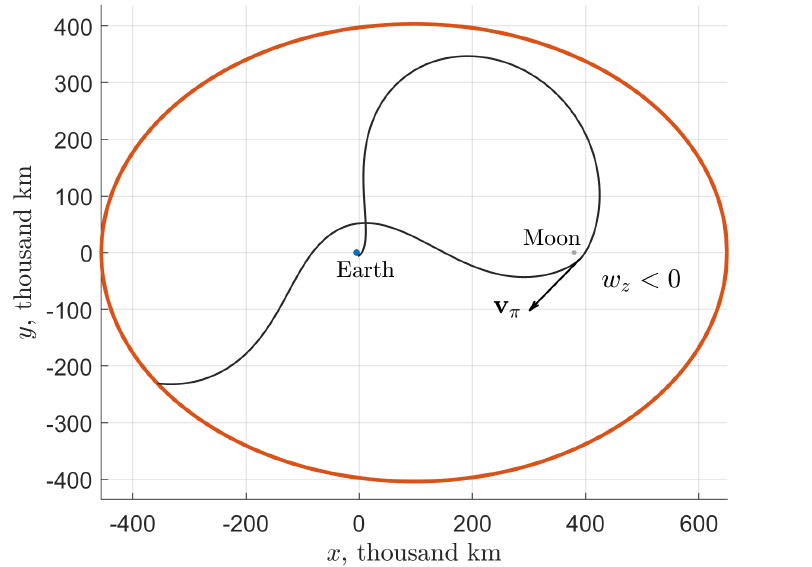
Figure 14. Sample departing leg with a retrograde lunar flyby. The orbital angular momentum relative to the Moon in the rotating frame is negative; the spacecraft crosses the x -axis behind the